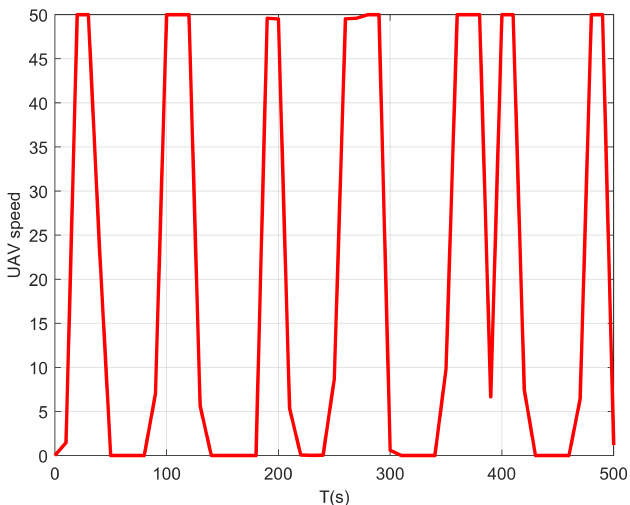
Figure 3. The UAV speed changes within flight duration T = 210